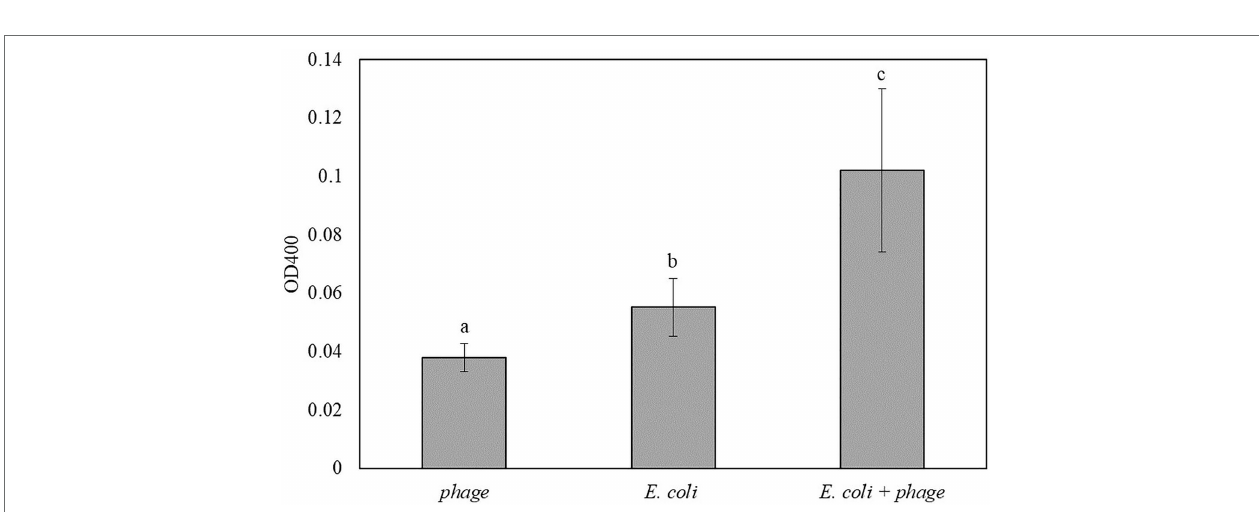
FIGURE 4 | The dE of the filter with 5 h-enriched 10 CFU/ml E. coli BL21 and 2 h infection with bacteriophage T7-ALP in 225 ml TSB with 25 g spinach leaves after enzymatic reaction with NBT/BCIP for 30 min. Treatments with “ * ” are significantly different ( p < 0.05). Error bars indicate ±standard deviation of means.